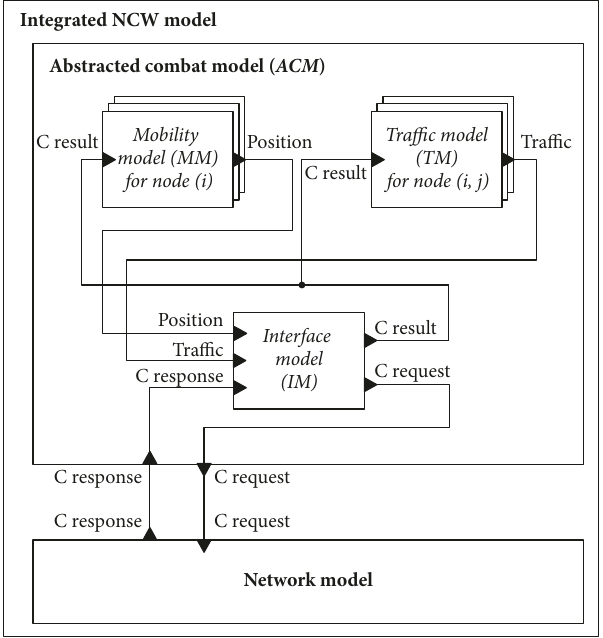
Figure 6: Overall NCW model structure including the abstracted combat model and the network